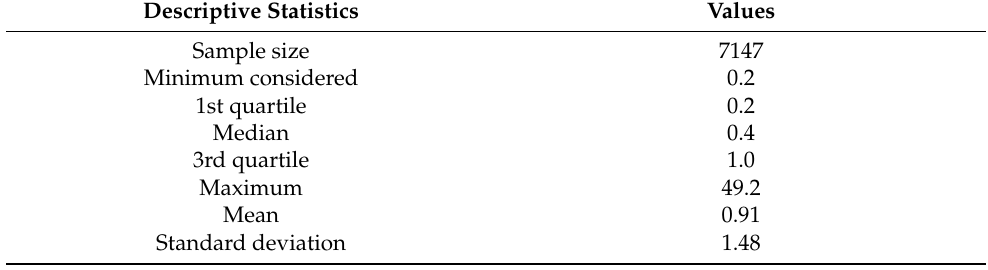
Table 1. Descriptive statistics of accumulated precipitation levels (mm) for each hour of precipitation in three locations between 2013 and 2019.